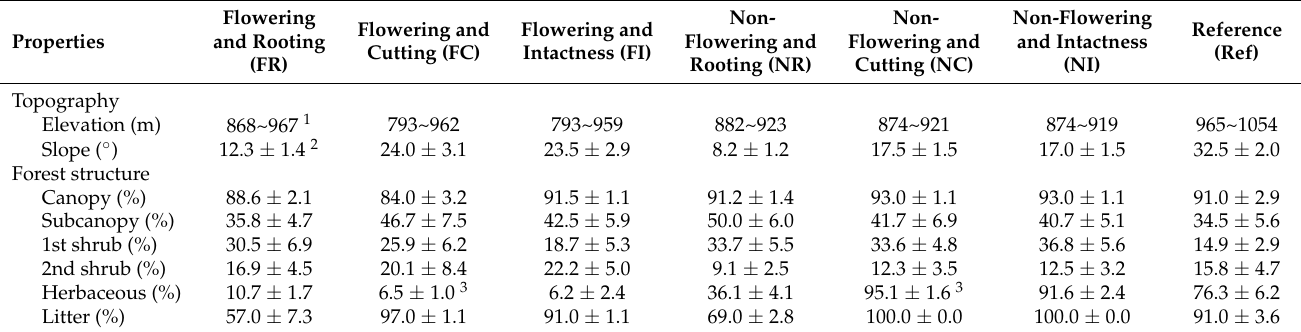
Table 1. Stand characteristics and forest structure at the permanent plots measured in